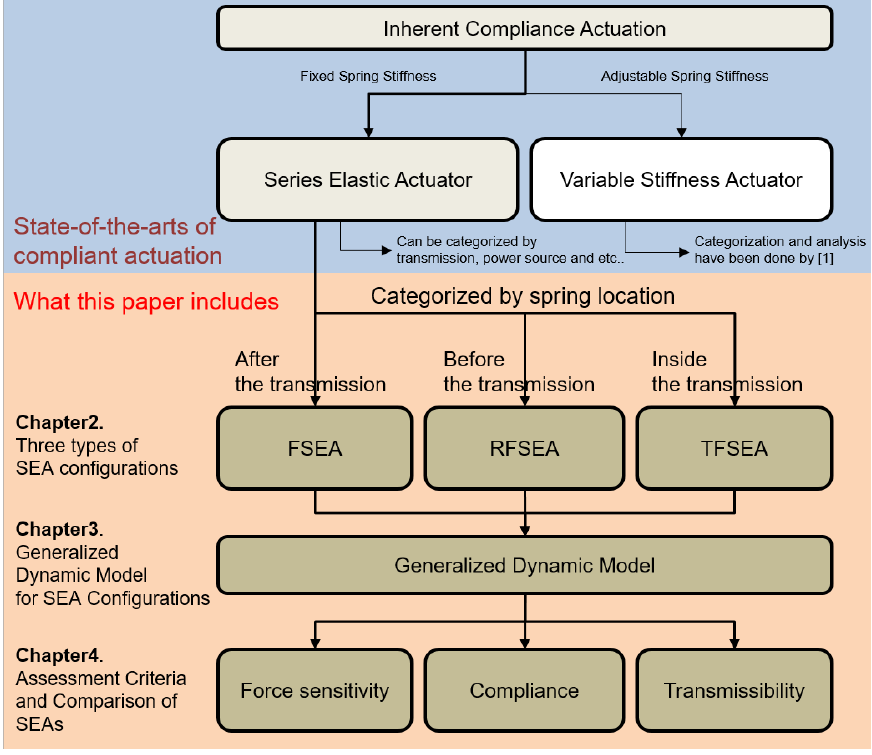
Figure 2. Overview of organization of this